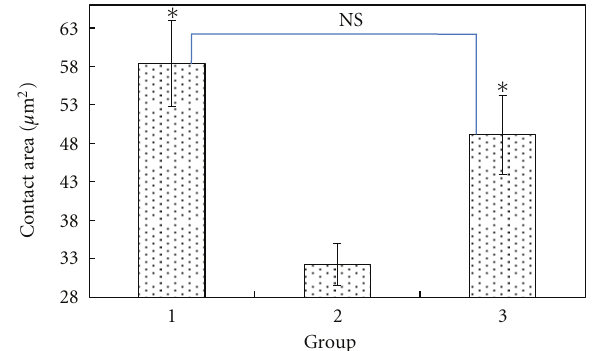
Figure 5: E ff ects of HgCl 2 on the erythrocyte section area: (1) normal erythrocytes, (2) normal erythrocytes were treated with hypertonic solution, and (3) normal erythrocytes were treated with HgCl 2 then the hypertonic solution. Data are means ± SD. N = 100. ∗ P < 0 . 05 versus the group 2 as control, and NS indicate no significant di ff erences between the two